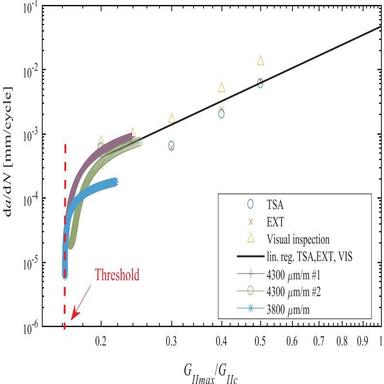
Paris curves from the load and strain control experiments.